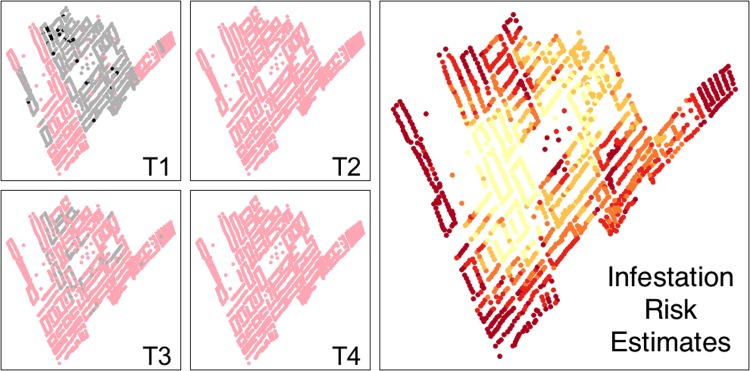
Map of a locality as represented in the model throughout the four time periods (T1-T4).Dots represent houses. T1 represents the time period of the ‘attack phase’ of the control campaign, which occurred between January 11th, 1997 and January 6th, 2014, depending on the district. In T1, grey dots represent houses that participated in the ‘attack phase’ of the control campaign but were not found to be infested with Triatoma infestans, and black dots represent houses that participated and were found to be infested with T. infestans. Time periods T2-T4 represent the time period of the surveillance phase (T2: January 7th, 2014—January 6th, 2016; T3: January 7th, 2016—January 4th, 2018; T4: the current calendar year, currently set to (at the time of this publication) January 5th, 2018—present). In T2-4, grey dots represent houses that were inspected and not found to be infested with T. infestans during the surveillance phase.